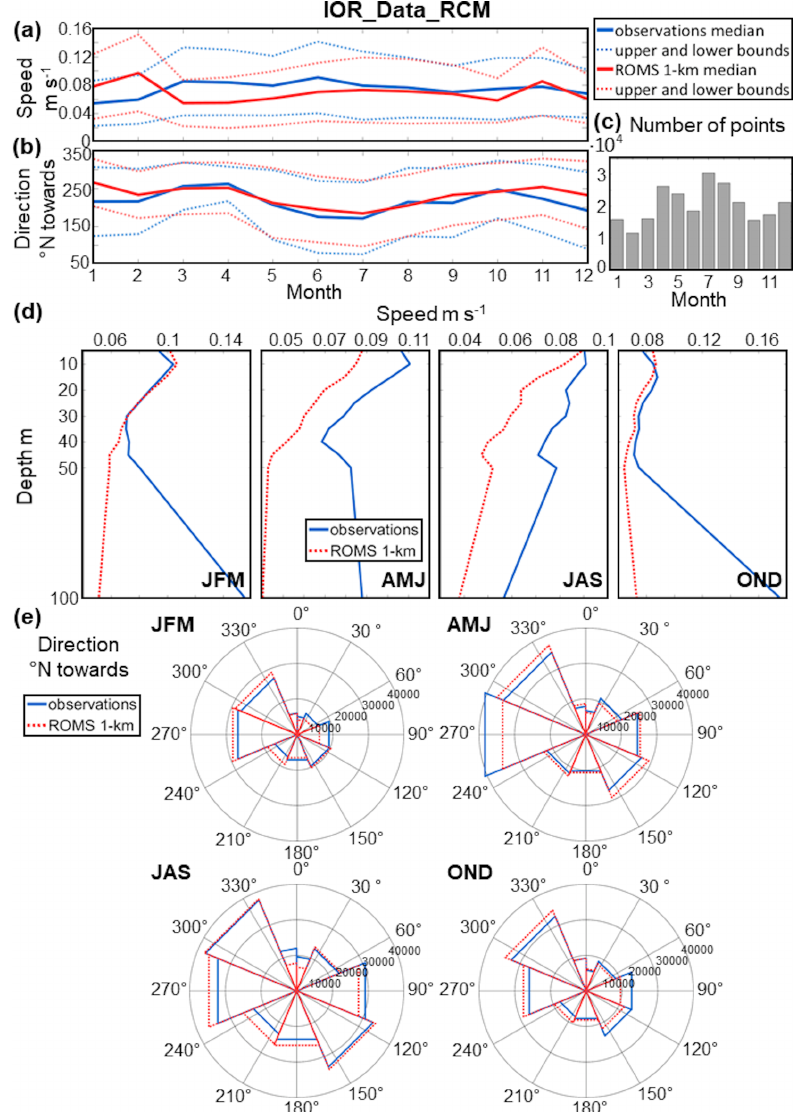
Figure 14. IOR_Data_RCM dataset. Monthly climatology of AdriSC 1km and in situ (a) median speed, (b) median direction, and their variabilities (i.e. upper and lower bounds defined as ± MAD) as well as (c) the number of observations per month. Seasonal variations of the (d) speed of the AdriSC ROMS 1km model and observations depending on the depth. Seasonal rose plots of the (e) direction for RCM observations and the AdriSC ROMS 1km